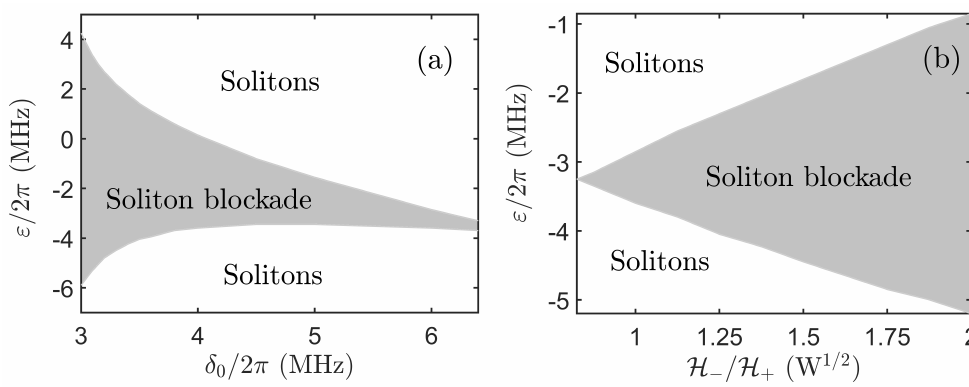
Figure 3. The soliton-blockade regions in the ( δ 0 , ε ) and ( H − / H + , ε ) planes. ( a ) H 2 ± = 16 W; ( b ) H 2 + = 16 W, δ 0 /2 π = 6 MHz.